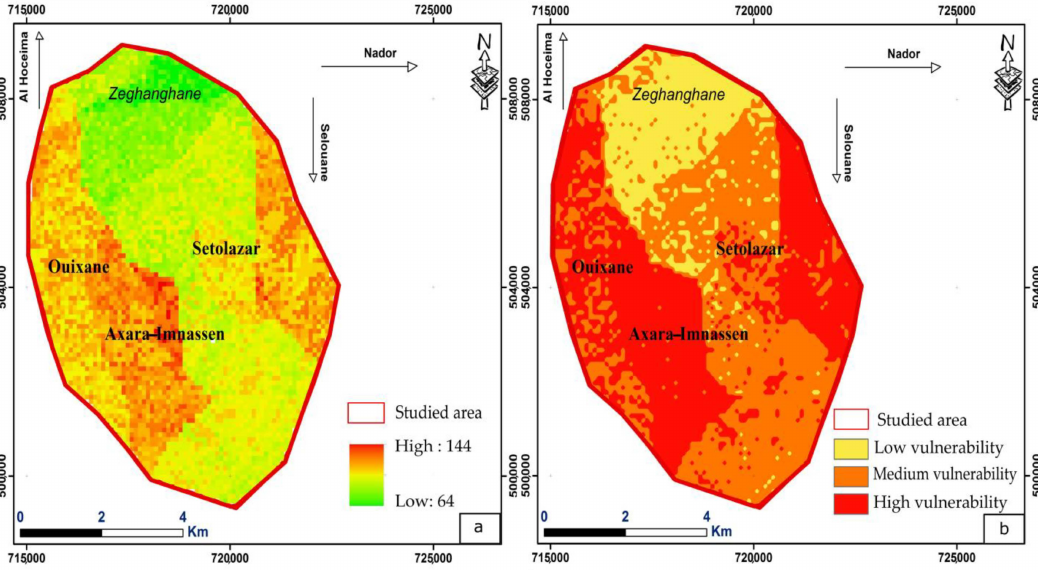
Figure 10. ( a ) Vulnerability index map. ( b ) Intrinsic vulnerability map of the studied